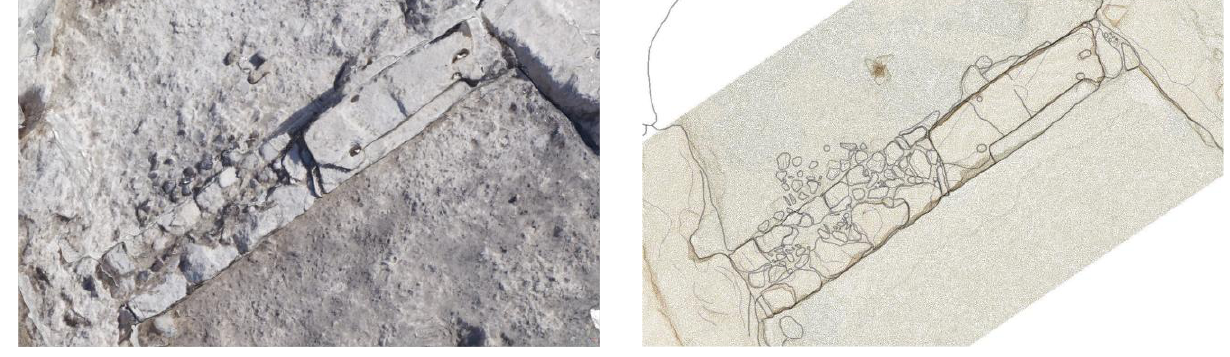
Figure 5. Detail of the workshop plan: mesh with photographic texture